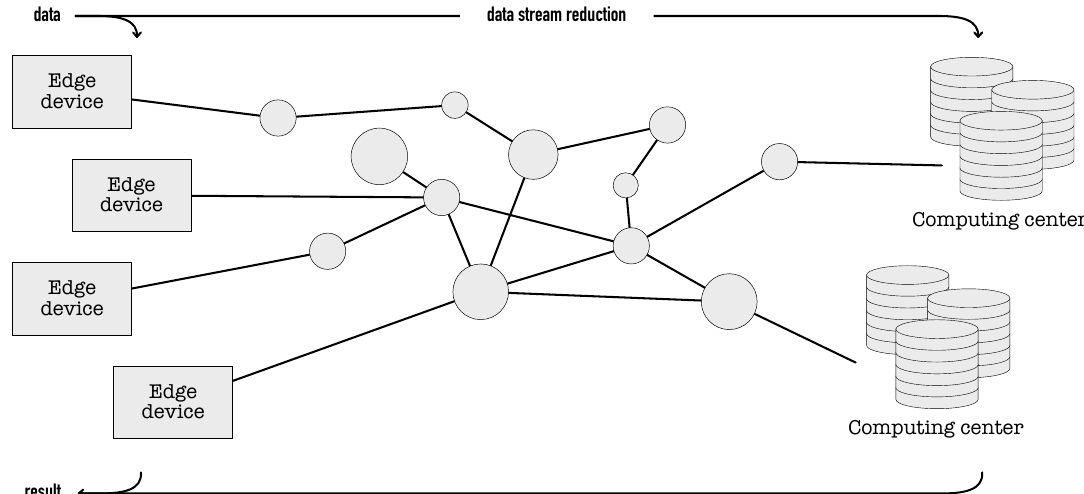
Figure 1. Data flow and processing stages in a standard system setup.